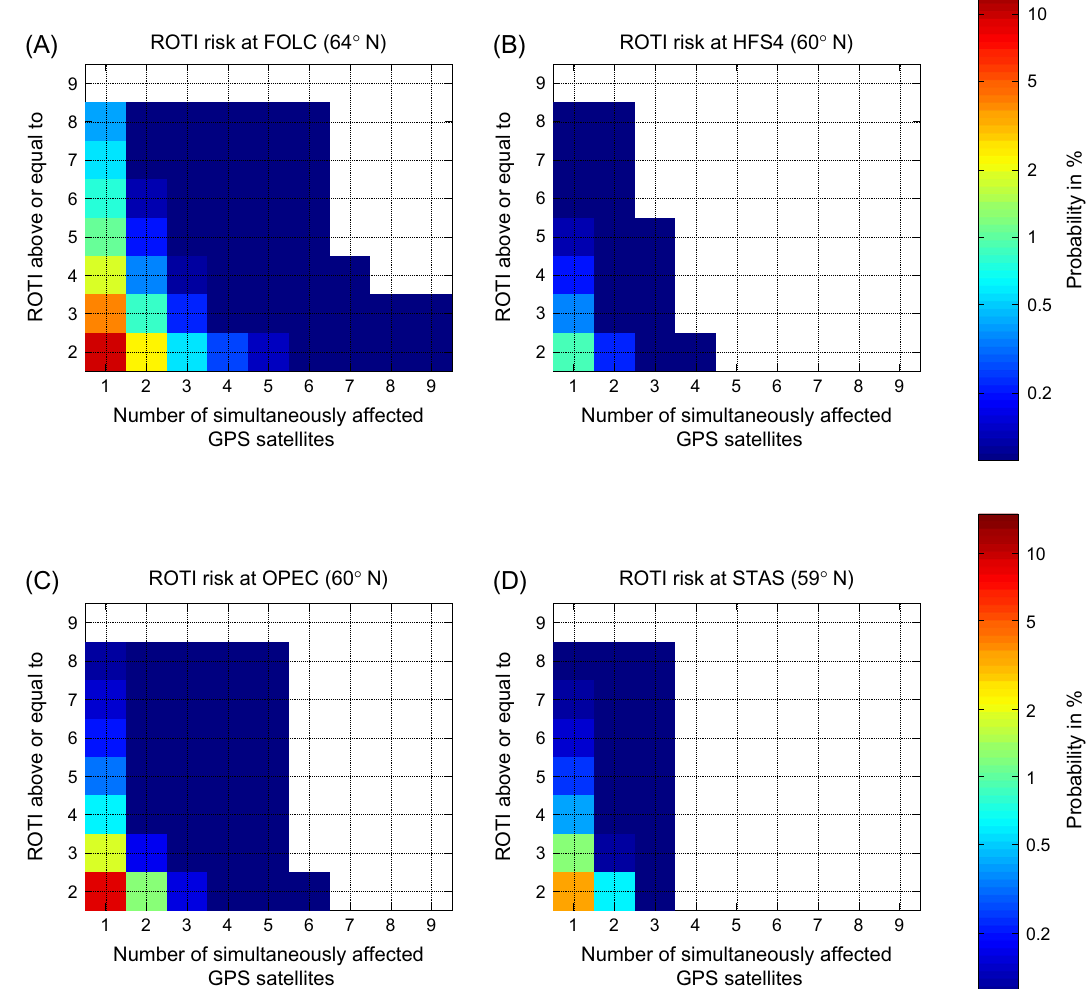
Fig. 12. Tables of the probabilities that ROTI exceeds threshold values simultaneously at several satellites, for these receivers: (A) FOLC, (B) HFS4, (C) OPEC, (D)